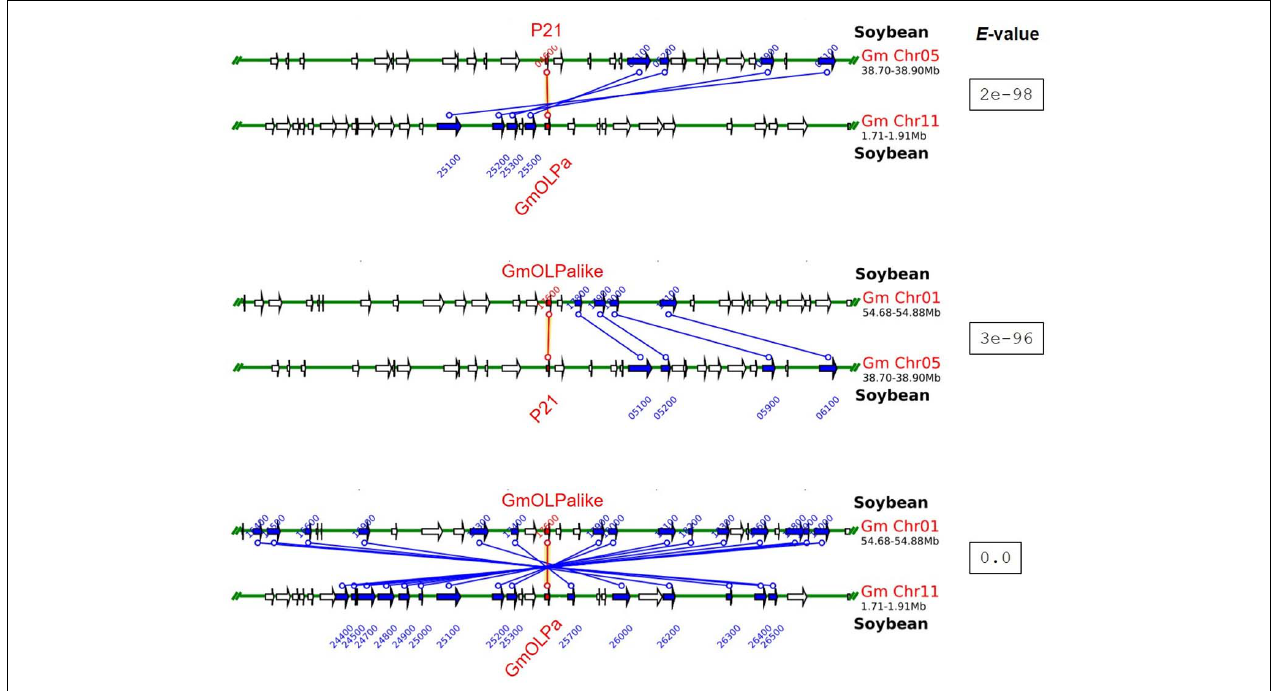
FIGURE 2 | Syntenic regions between paralogous soybean osmotin genes. Green horizontal lines represent the chromosomes. Blue and red vertical lines and arrows represent the duplicated paralogous genes. The red lines represent the sequence used as the search query (indicated at the top of each syntenic region). The white arrow indicates no duplicated genes. The e -value for each syntenic region is